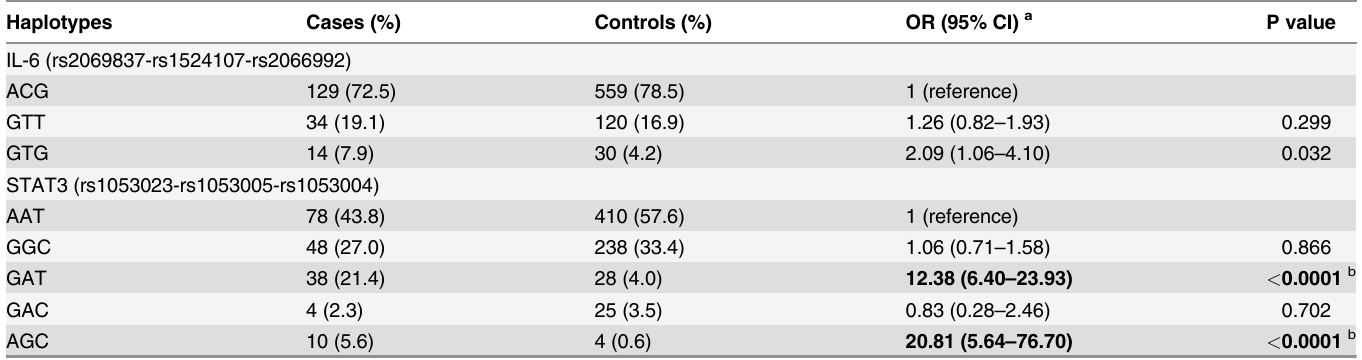
Table 4. ORs and 95% CIs for ATDH in relation to IL-6 and STAT3 haplotypes.